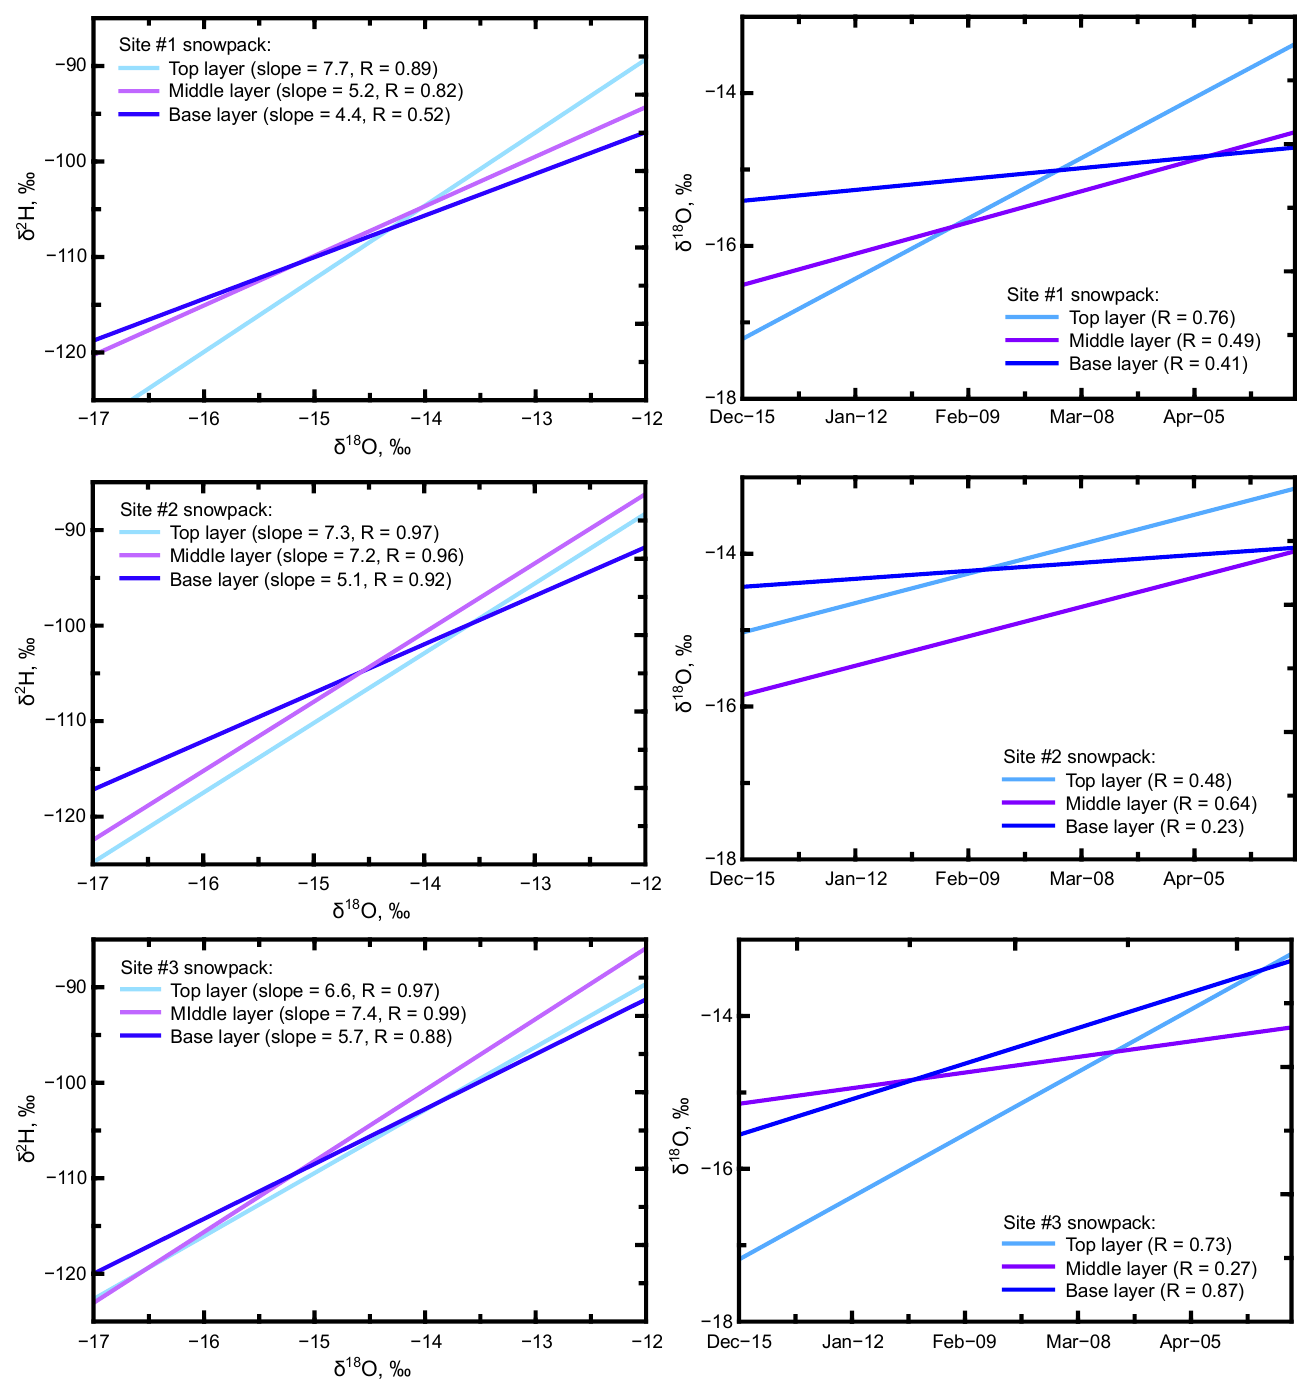
Figure 7. Linear regression trendlines of δ 2 H and δ 18 O and δ 18 O with time for the snowpack sampling sites by layer.